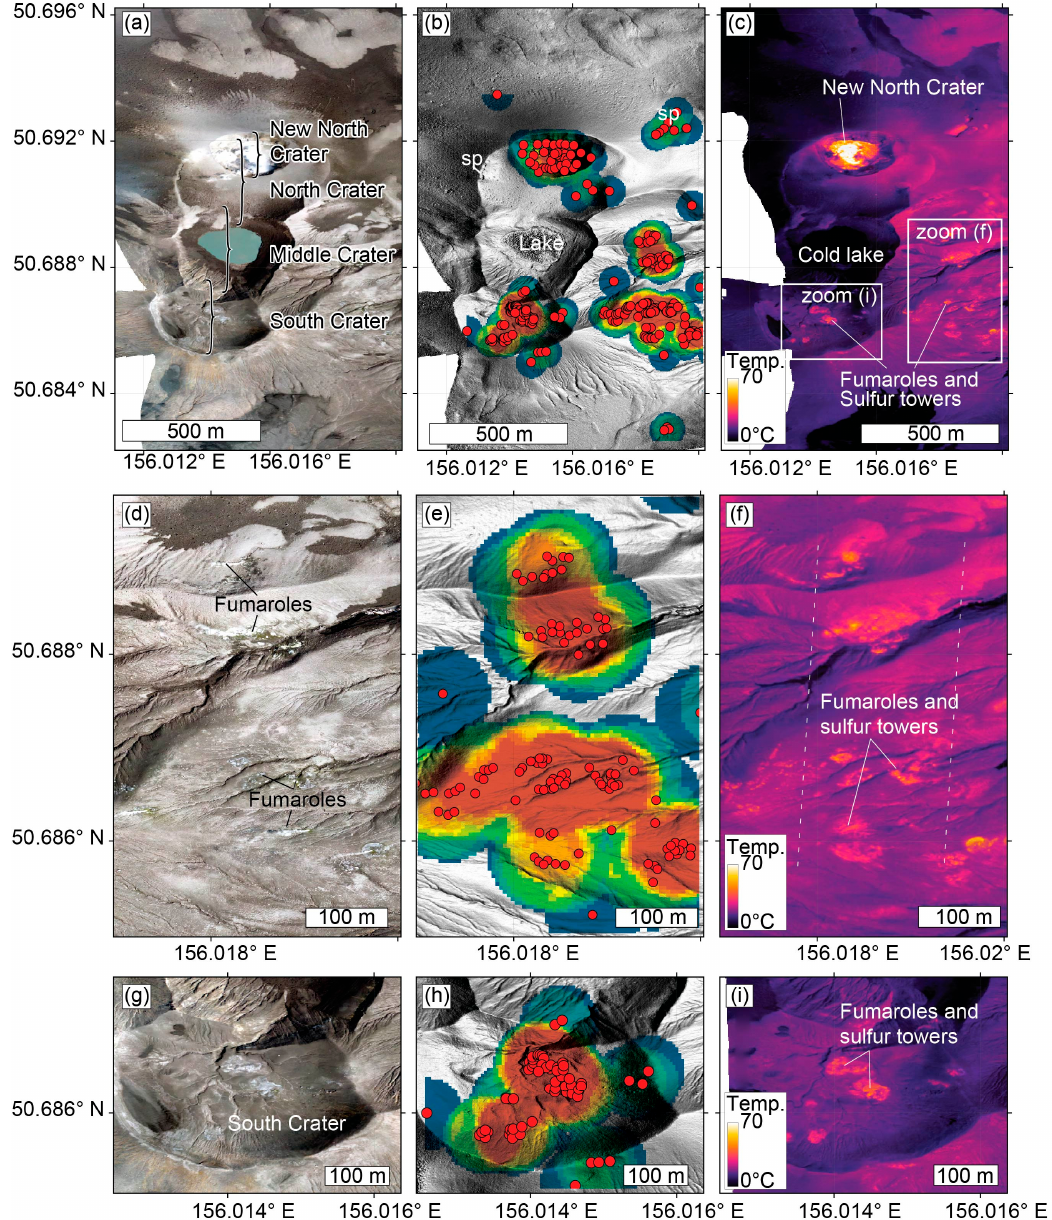
Figure 3. Results from the UAS survey. ( a ) Orthophoto generated from optical UAS camera data using the Structure from Motion (SfM) approach. ( b ) Thermal spots associated with hot springs and fumaroles identified from thermal cameras and optical data (shown by red dots) and cluster analysis (red shades indicate high clustering density) overlapped on a shaded relief digital terrain model generated from the optical UAS data. sp—subsidence pits. ( c ) Thermal infrared orthophoto. White boxes show close-ups as illustrated in the center and lowest row of the figure. Note that thermal spots cluster in fields, with a local alignment associated with ravine and ridge topography (panel e). Thermal spots are also located at sites of former eruption vents, as in the South Crater (panel i).